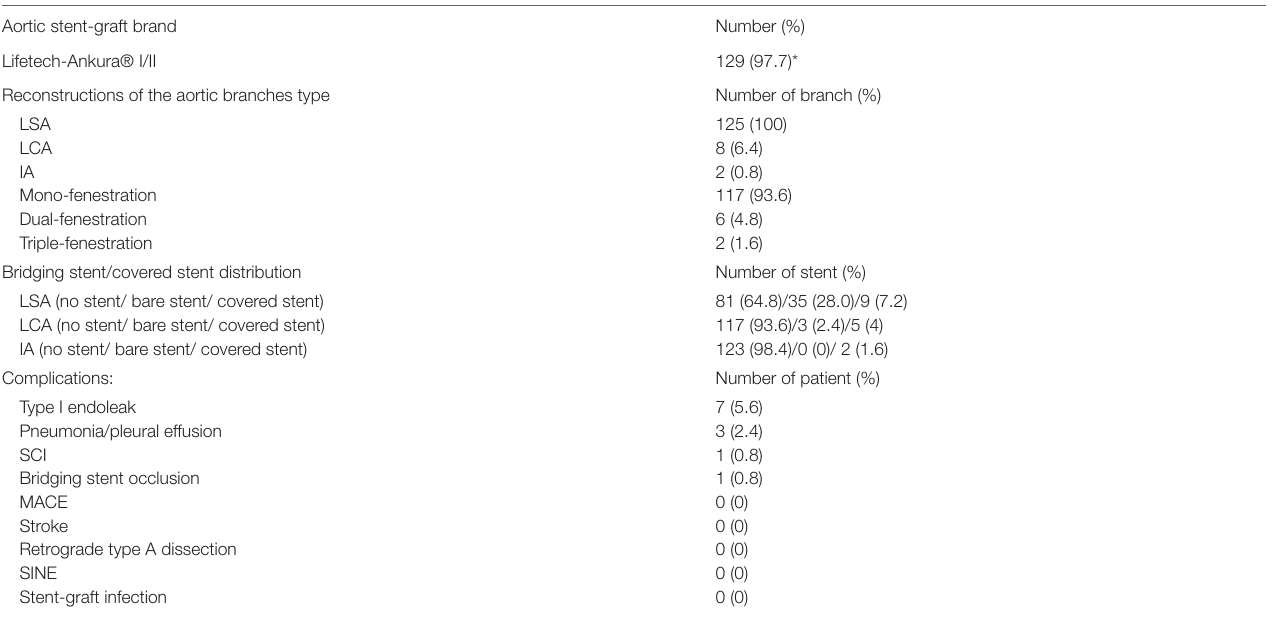
TABLE 2 | Information in SF-TEVAR procedures and peri-operative complications (within 30 days of SF-TEVAR). Aortic stent-graft